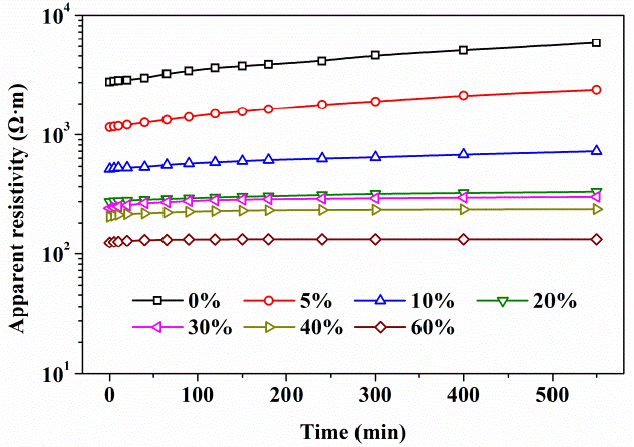
Figure 3. Change of apparent resistivity with sediment fraction ( v / v ) (from 0% to 60%) and draining time (from 0 min to 550 min).